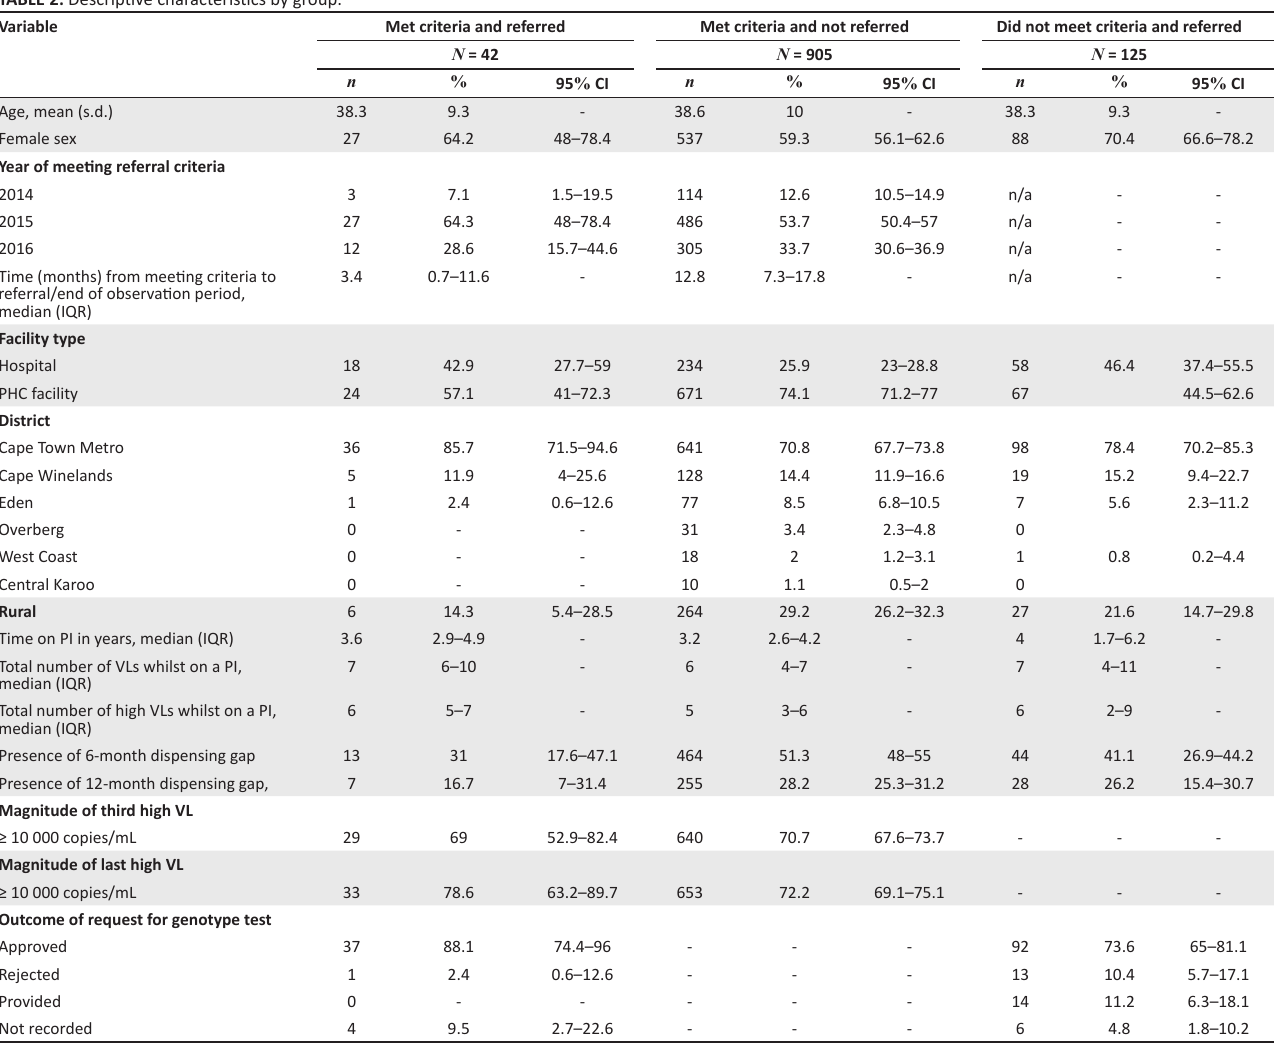
TABLE 2: Descriptive characteristics by